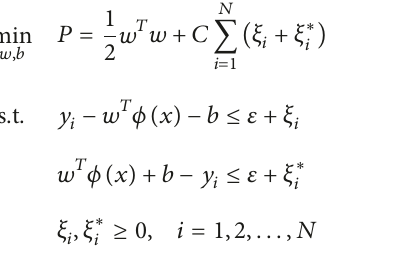
Penalty parameter 𝐶 and the kernel parameter 𝜎 play a significant role in the model generalization. Particle swarm optimization (PSO) algorithm is introduced to find the optimal parameters. The hybrid PSO-SVR method treats the parameters 𝐶 and 𝜎 as the particles, and the velocity and location are constantly